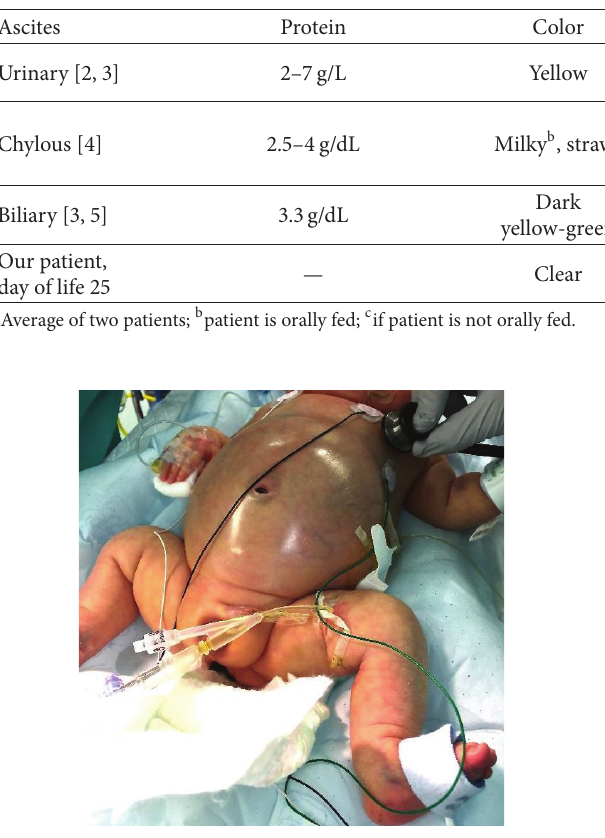
Table 1: Comparison of biochemical profile of the results of peritoneal taps reported in the literature.